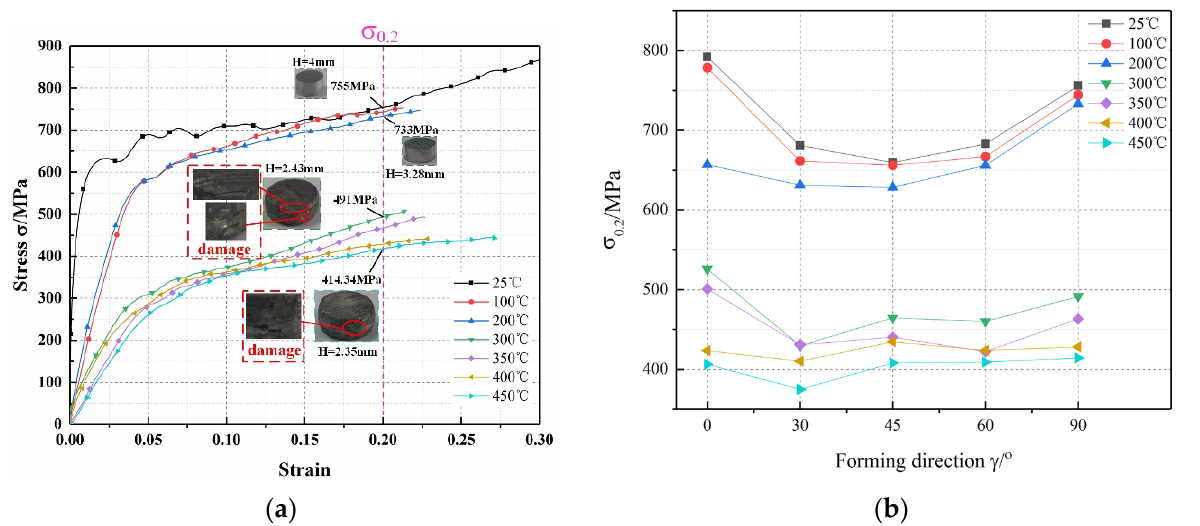
Figure 7. High-temperature mechanical characteristic curve of AA7050-T7451 (strain rate: 0.4 × 10 4 s − 1 ). ( a ) Stress–strain curves at different temperatures ( RD ). ( b ) Variation in the stability stress with γ at different temperatures .